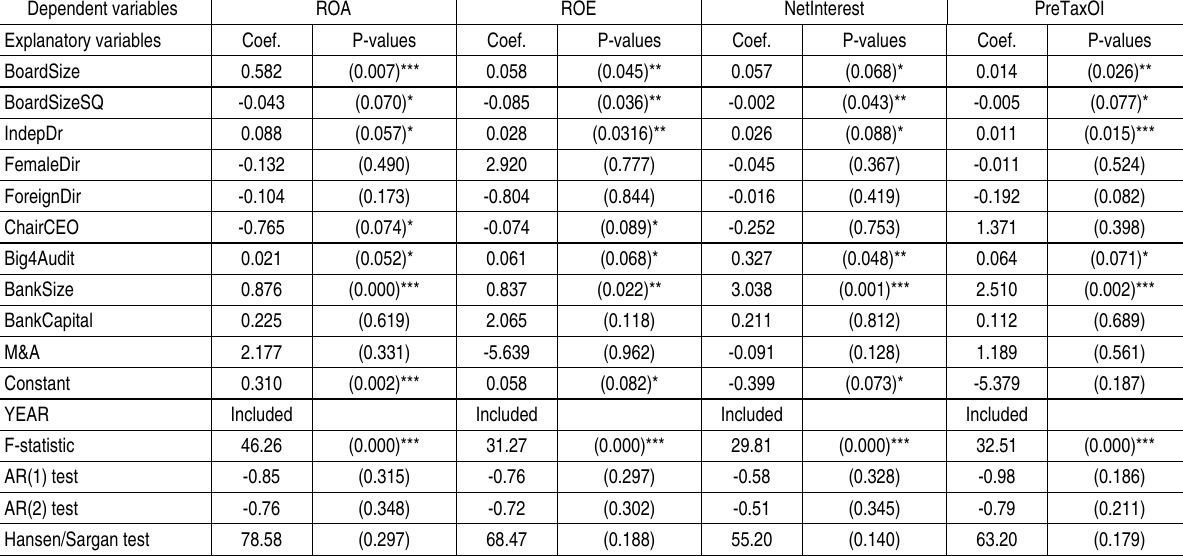
Table 4. Two-step system GMM empirical findings with the inclusion of BoardSizeSQ Dependent